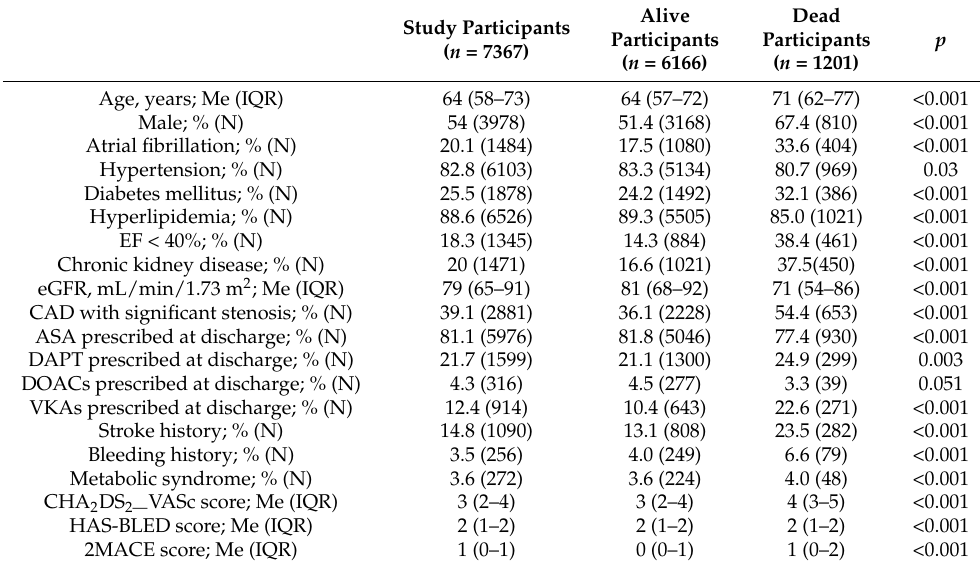
Table 1. Baseline characteristics with a comparison between alive and dead participants of the study.